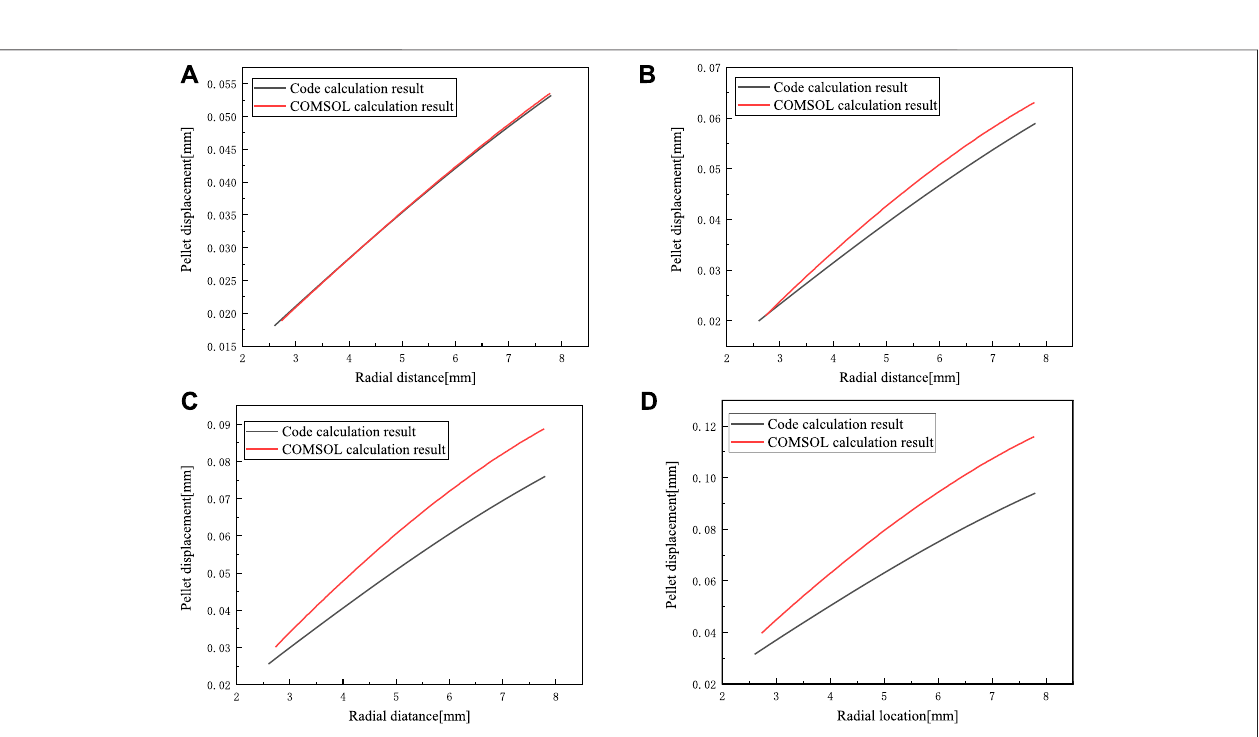
FIGURE 8 | (A) (B) (C) (D) are the displacement comparison results of the fuel at 1, 100, 500, and 1,000 days.